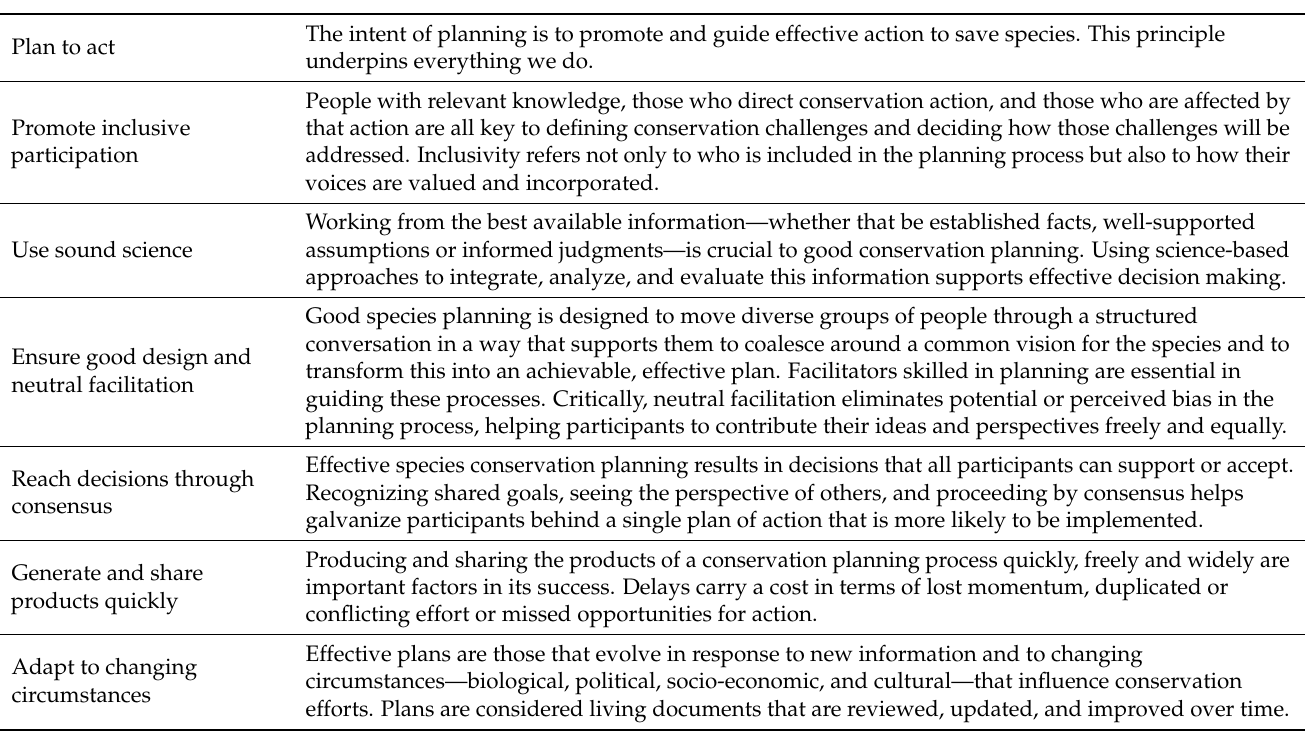
Table 1. SSC CPSG Species Conservation Planning